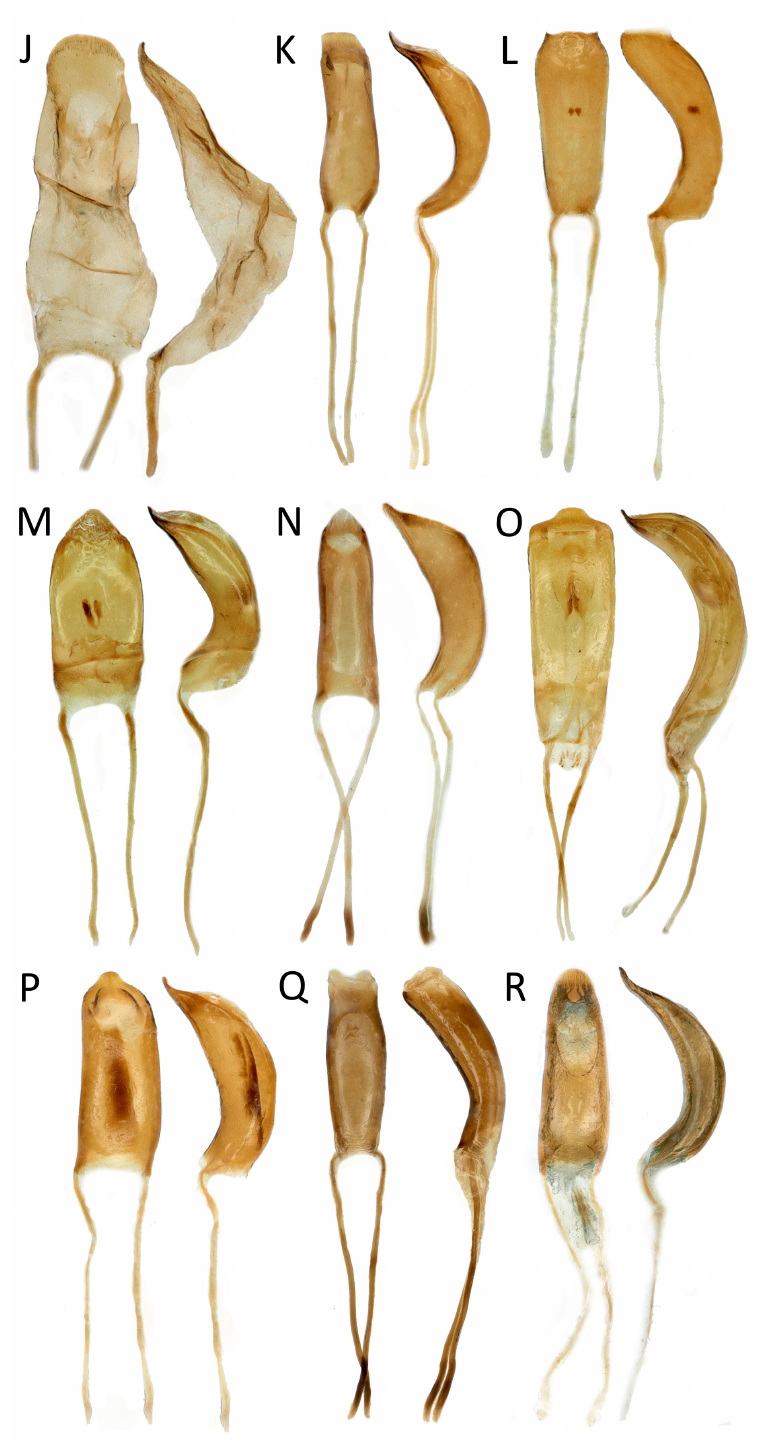
Fig. 6 (part 2). J–R . Male genitalia of Ebenacobius Haran gen. nov.. penis in dorsal (left) and lateral (right) view. J . E. mulanjensis Haran gen. et sp. nov. K . E. hessei Haran gen. et sp. nov. L . E . pedi Haran gen. et sp. nov. M . E . tsonga Haran gen. et sp. nov. N . E . hippopotamorum Haran gen. et sp. nov. O . E . incognitus (Hesse, 1929) gen. et comb. nov. P . E. oberprieleri Haran gen. et sp. nov. Q . E . turneri (Marshall, 1935) gen. et comb. nov. R . E . rhodesianus (Hesse, 1929) gen. et comb. nov. J–R = not to